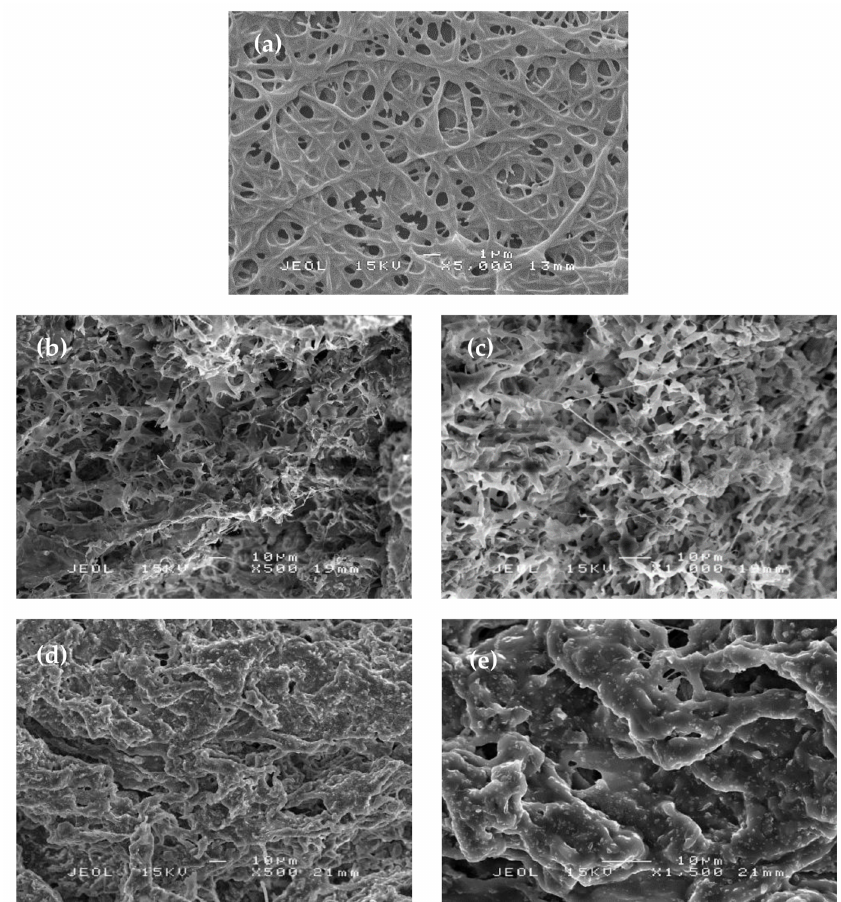
Figure 7. SEM images of ( a ) cross-linked CMSP hydrogel nanofibers; ( b , c ) swollen CMSP hydrogel nanofibers; and ( d , e ) methylene blue (MB)-loaded CMSP hydrogel